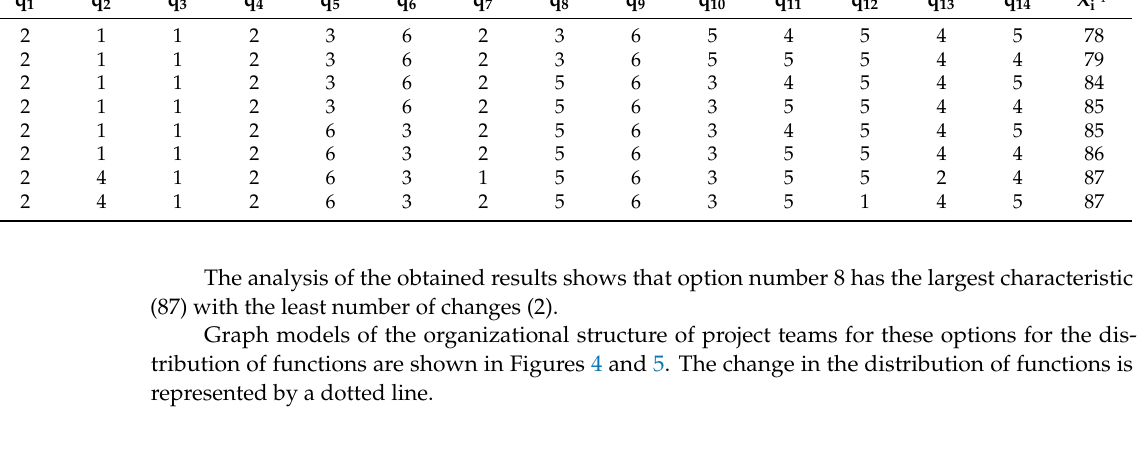
Figure 4. Graph model of the organizational structure of the project team (distribution option 7).